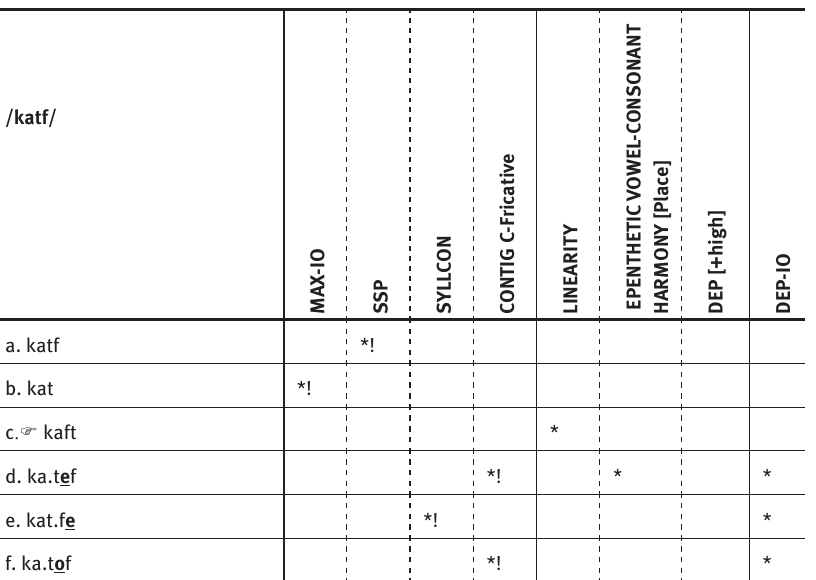
Table 11: MAX-IO, SSP, SYLLCON, CONTIG C-Fricative>>LINEARITY, EPENTHETIC VOWEL-CONSONANT HARMONY [Place],